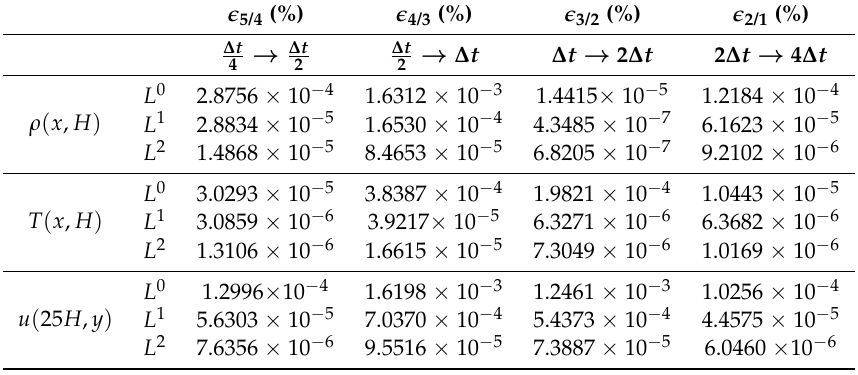
Table 8. Relative difference among L 0 , L 1 and L 2 norms of the absolute error achieved using different time step sizes. Results obtained with fine mesh and second-order, two-stage SSP–RK scheme and shown for density and temperature in the centerline of the microchannel and stream wise velocity in the cross section x = 25 H . Results obtained at the final time T f = 80 µ s with Kn = 0.05 and N =